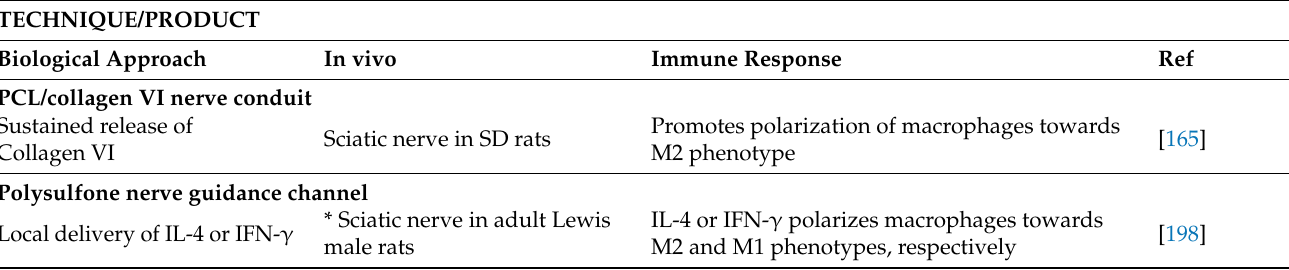
Table 3. Therapeutic molecule incorporation to induce macrophage polarization during